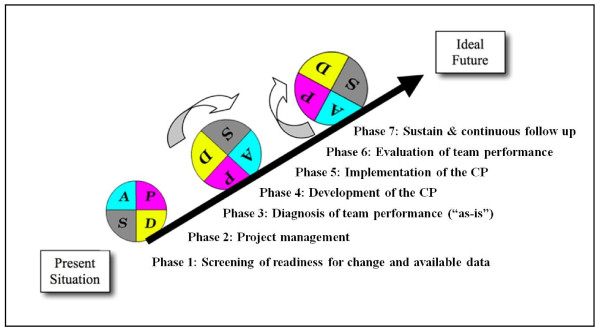
Care pathway implementation protocol based on the Deming-PlanDoStudyAct cycle.